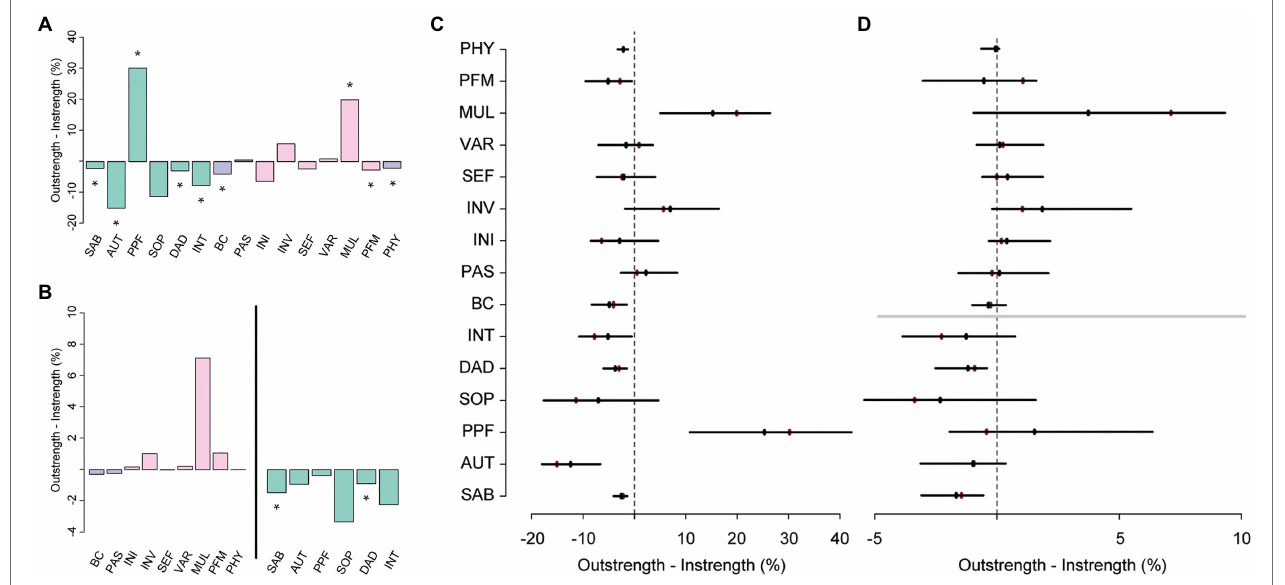
FIGURE 6 | The difference between overall outstrength and instrength of the nodes in the third network (A) , and the difference in outstrength and instrength of the relationships between the resilience factors and QoL facets only ( B , left), and the relationships between the QoL facets and the resilience factors ( B , right). Colors correspond to the nodes in the network in Figure 5 . In plots (C,D) , the bootstrapped mean is depicted in black and the sample mean in red. * p < 0.05, nodes with quantile intervals containing zero are deemed to have an insignificant instrength and outstrength